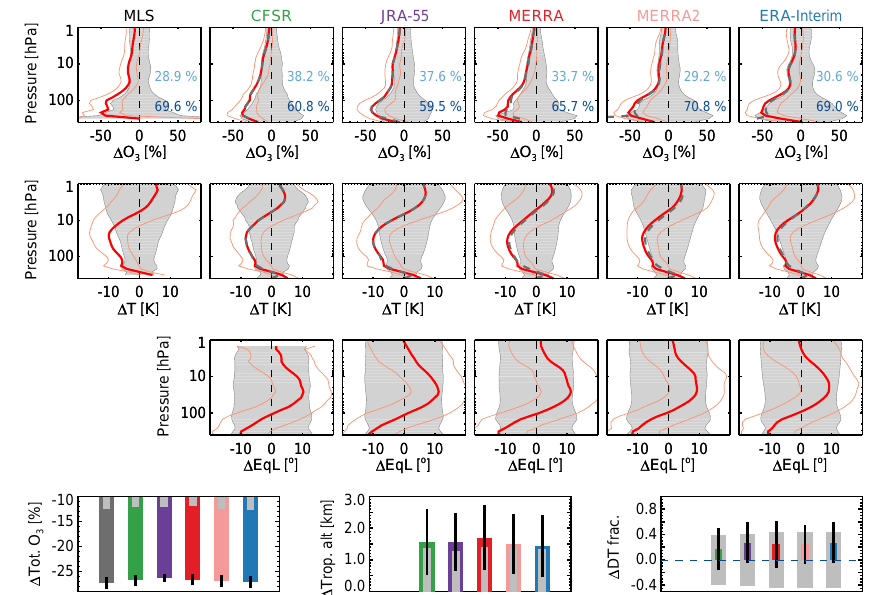
Figure 9. Composite of the difference between the events and the reference values for all mini-hole events found between 2005 and 2014. The first row shows the ozone vertical profile differences. The ozone composite event difference profile is shown in red, its 1 standard deviation envelope is shown by the thin light red lines, and the gray envelope is the reference composite standard deviation. In the reanalysis panels, the blue dashed lines show the ozone composite event difference when the MLS averaging kernels were applied. The percentage ozone reduction with respect to the total column of ozone in the UTLS and in the mid-stratosphere is shown in dark and light blue, respectively. Similarly, the second row displays the temperature profile differences and the third row displays the EqL vertical profile differences. Lastly, the fourth row shows the percentage difference of the total ozone column, the tropopause altitude difference, and the DT fraction deviations (dark gray, green, blue, red, pink, and purple bars represent the OMI, CFSR, ERA-Interim, MERRA, MERRA-2, and JRA-55 differences, respectively). In this column, light gray bars show the composite reference standard deviation, color bars show the corresponding composite event difference, and the black lines display the composite event difference standard deviation.